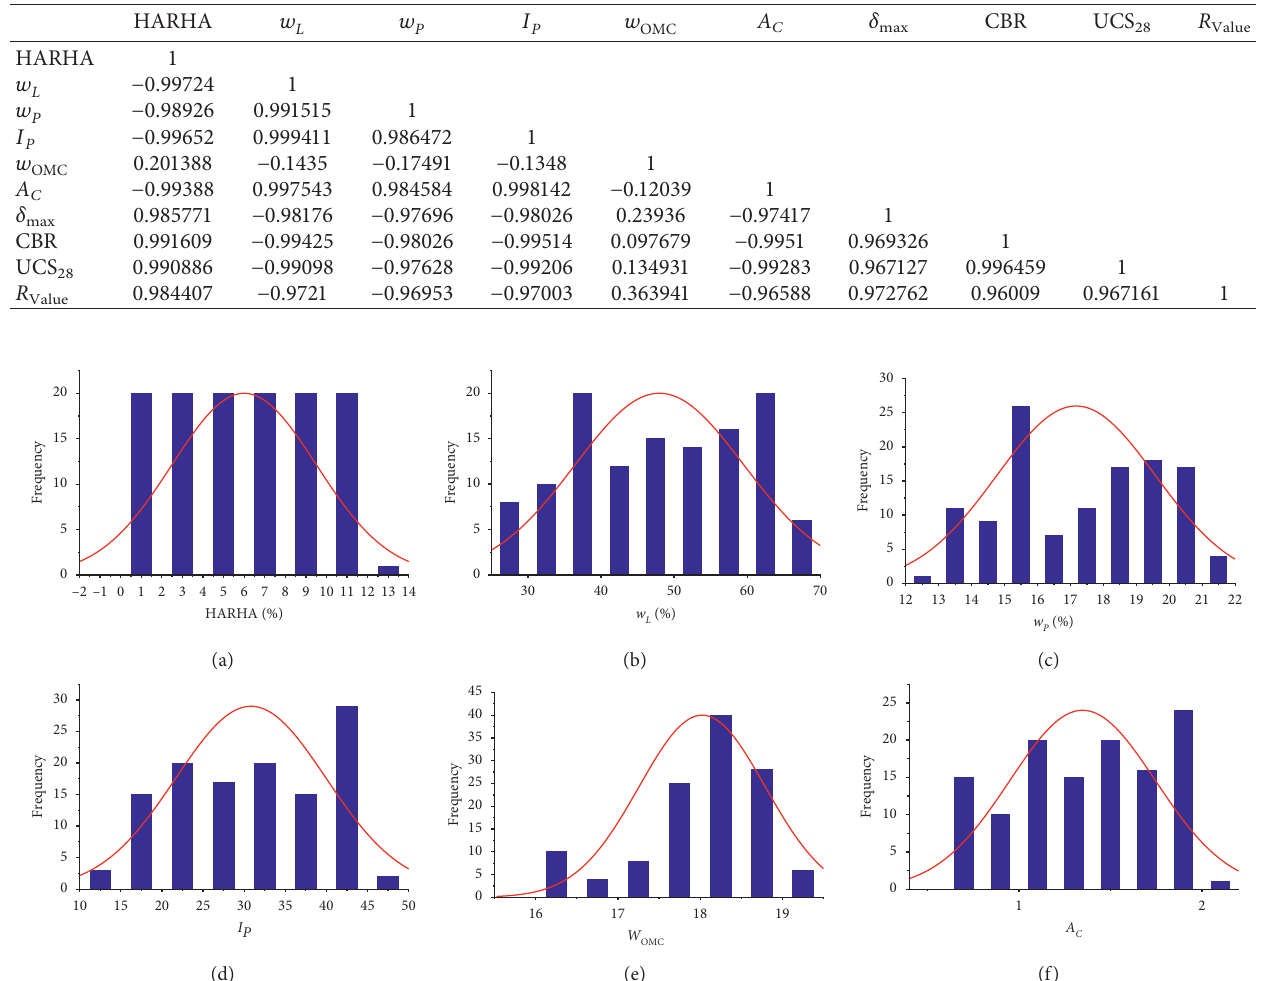
Table 2: Pearson correlation matrix for input and output parameters.